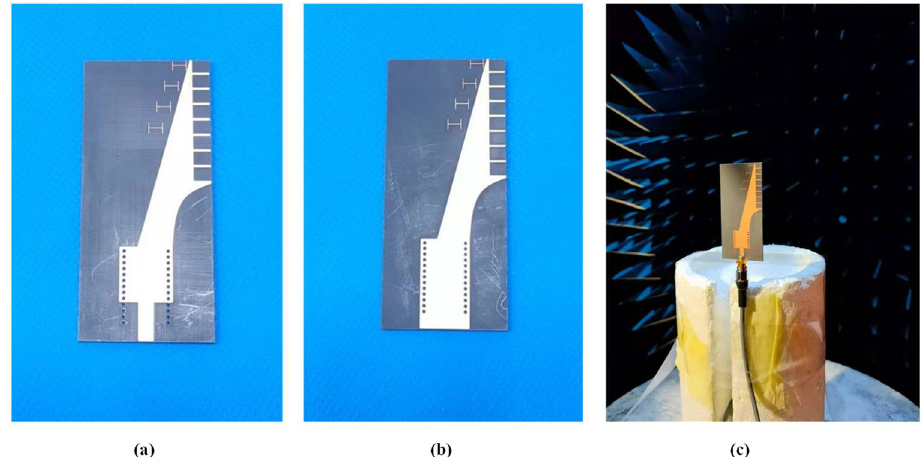
Figure 7. ( a ) Top view of the fabricated antenna. ( b ) Bottom view of the fabricated antenna. ( c ) Photograph of the measurement scene.